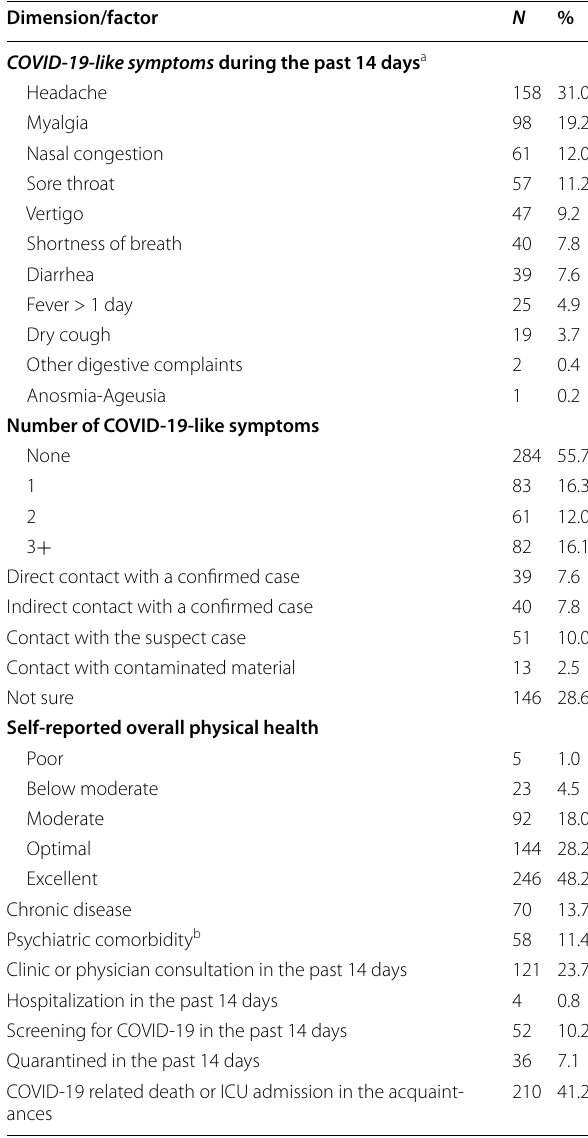
Table 2 Risk factors and epidemiological data ( N